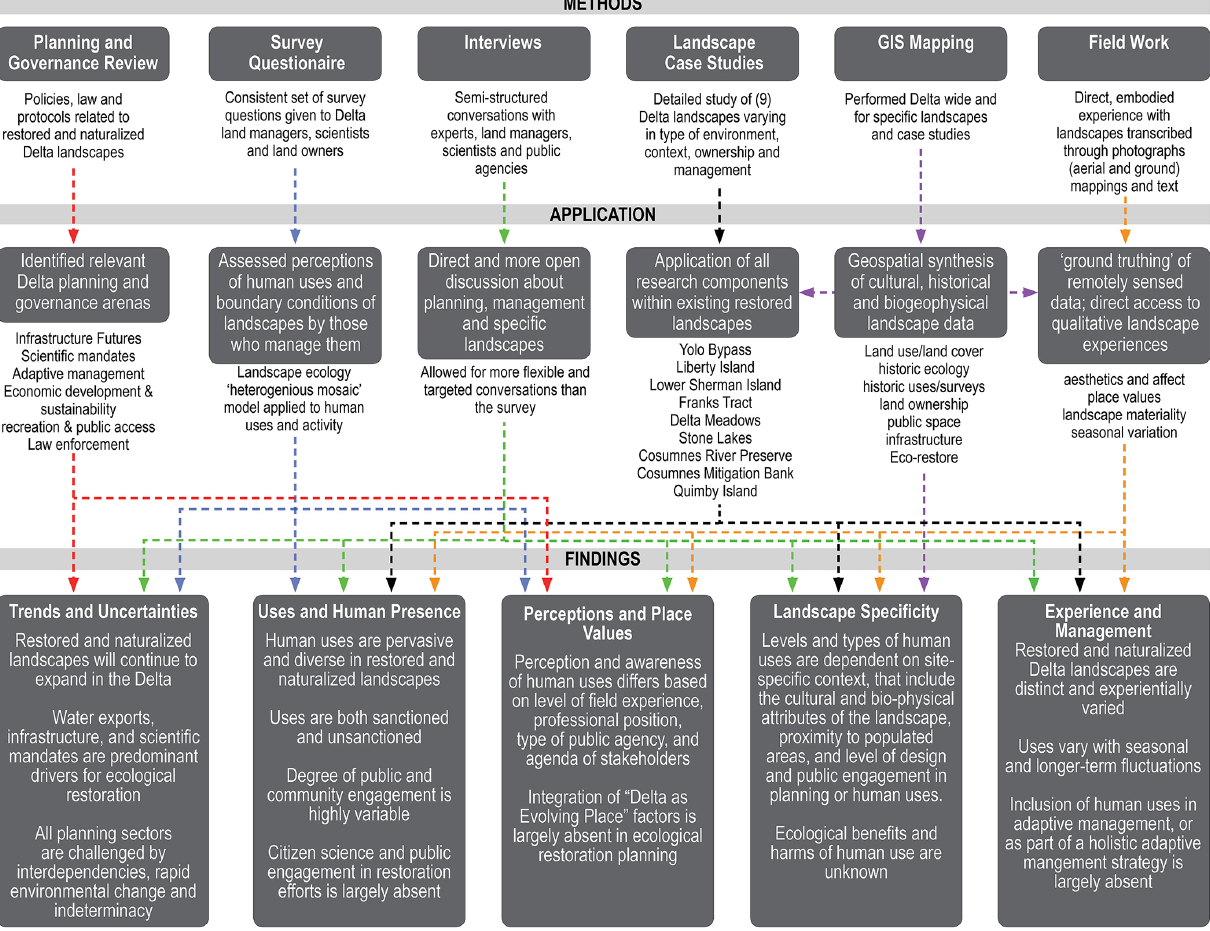
Figure 5. Research Methods Diagram deployed in the Human use of Restored and Naturalized Delta Landscapes study (from Milligan & Kraus-Polk, 2017). The diagram depicts six different methods, how they were applied and how each method contributed to the study’s